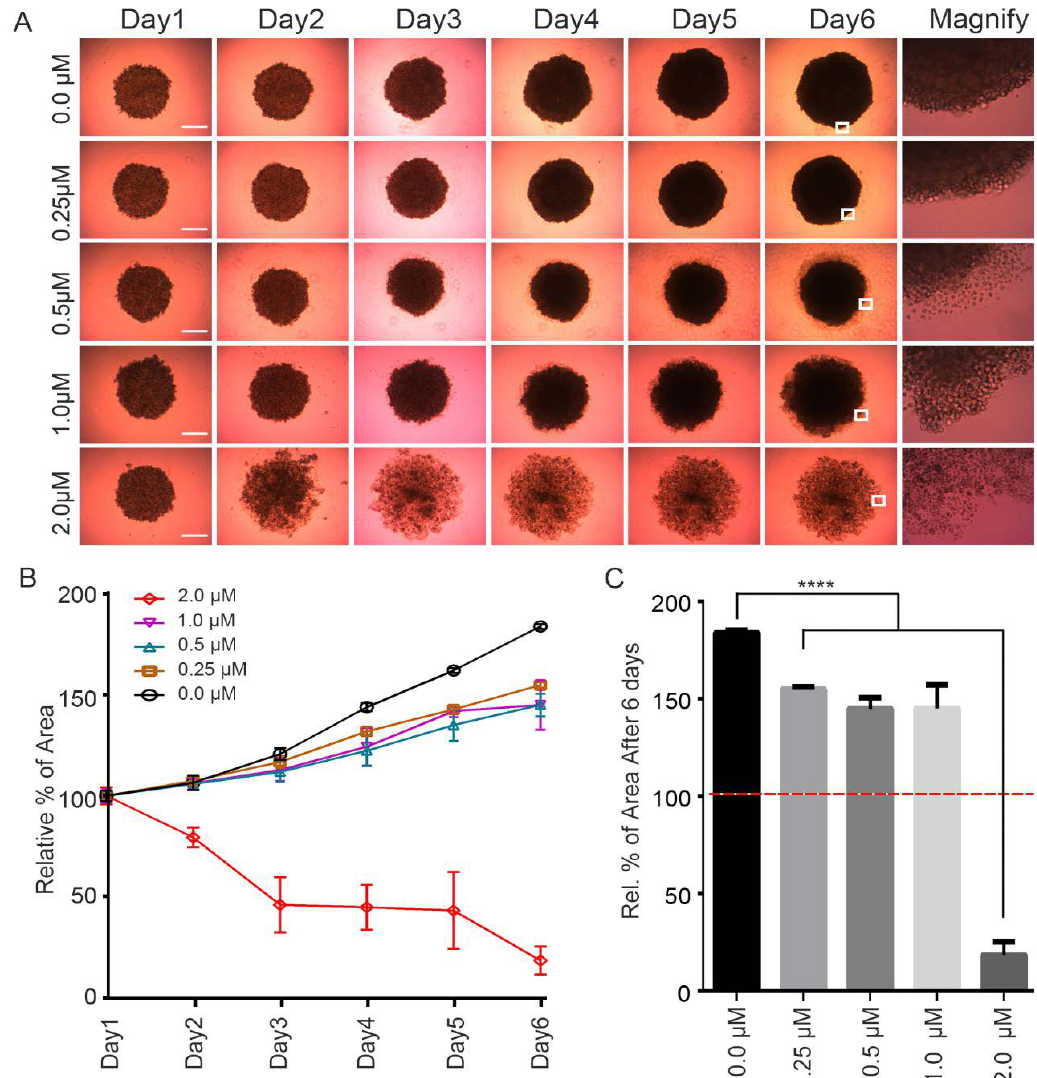
Figure 2. CPPF anticancer e ff ect on 3D culture system. ( A ) HeLa cells were seeded in 96-well round-bottom low attachment plate and treated with di ff erent concentrations of CPPF. Images were captured using a Zeiss Primovert microscope. The scale bar is 100 µ m; ( B ) Spheroid areas from D were calculated using Image J. Data presented as the mean ± SD of three independent experiments; ( C ) The spheroid area on day 6. The red line represent start point of spheroid area for CPPF treatment. Error bars represent means ± SD from three independent experiments, **** p -value < 0.0001.